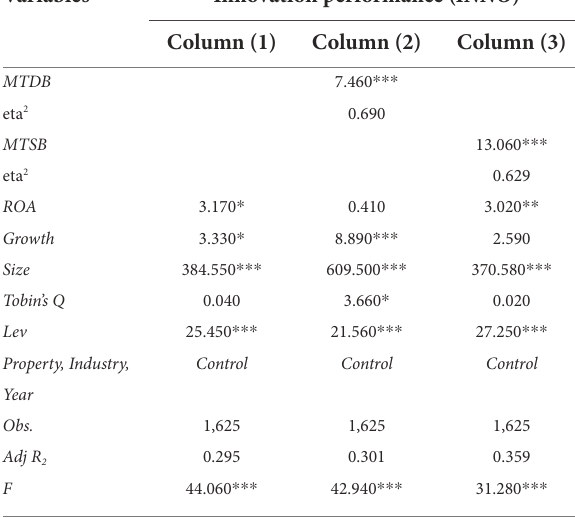
TABLE 5 Covariance analysis of dual network matching effect on firms’